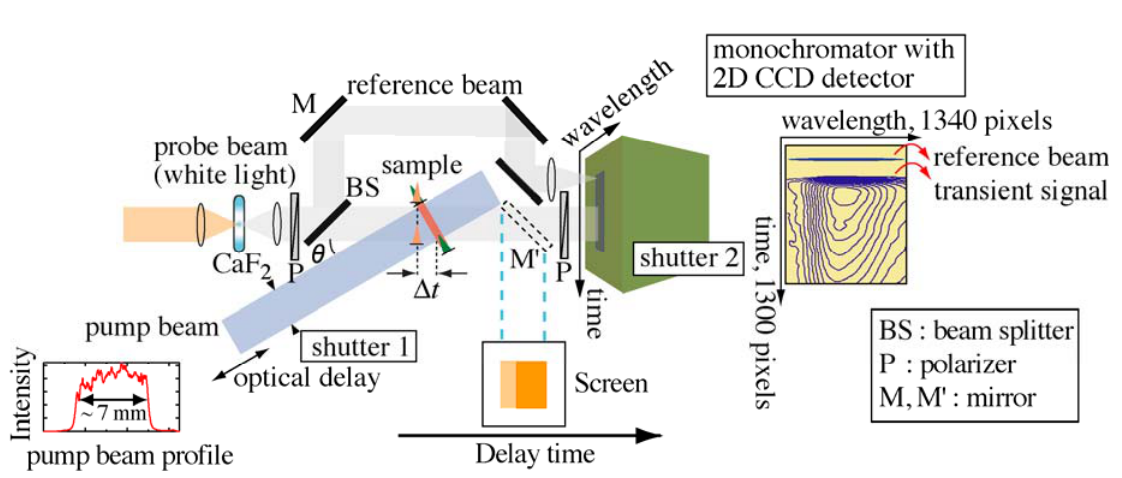
Figure 1. Schematic experimental apparatus for real-time pump-probe imaging spectroscopy implemented on a single shot